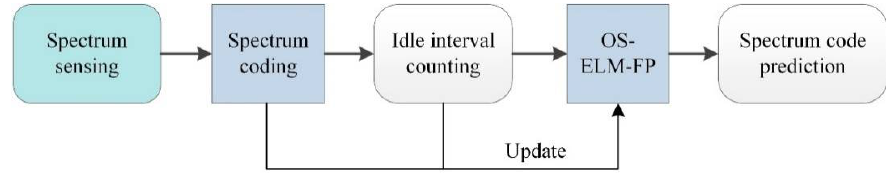
Figure 2. Block diagram of the active interference activity prediction in the frequency domain.